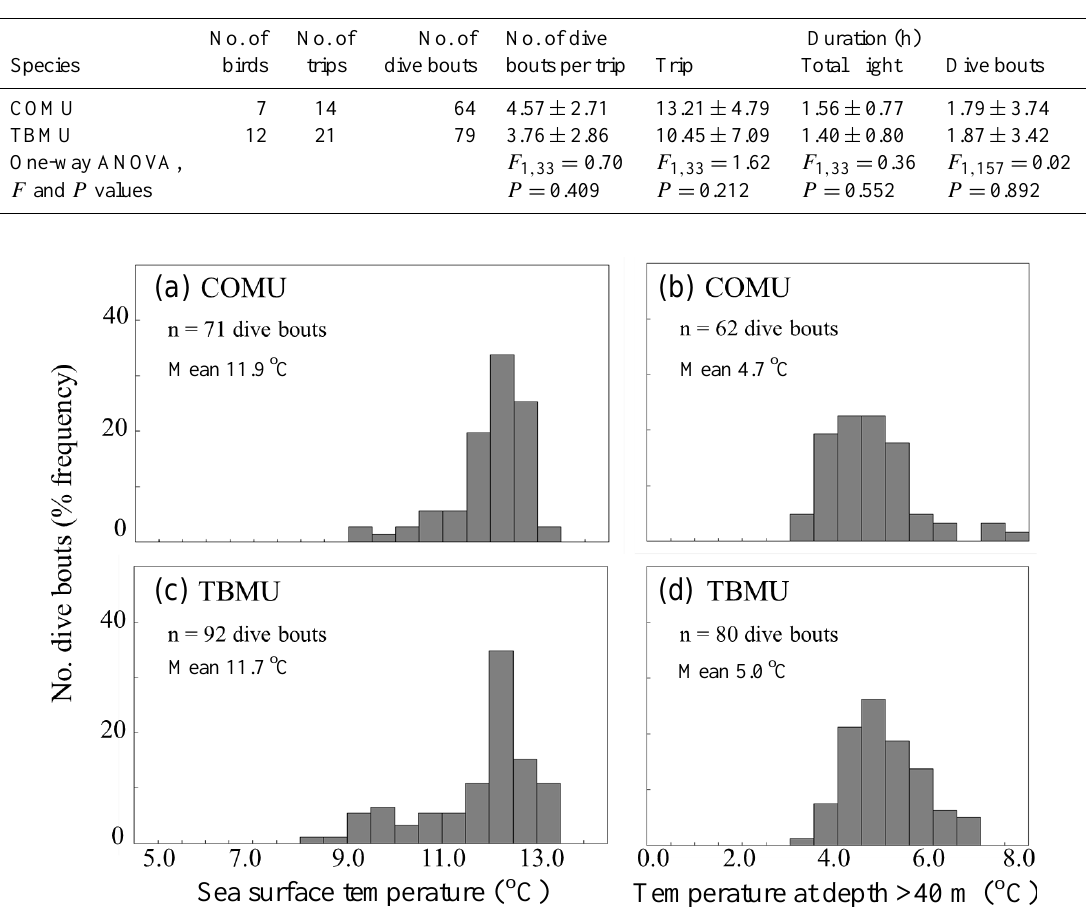
Figure 1. Frequency distribution of dive bouts in relation to (a) and (c) sea surface temperature (SST) and (b) , (d) mean temperature at depth (>40m) in the water column. Upper panels represent data for common murres (COMU) and lower panels represent data for thick-billed murres